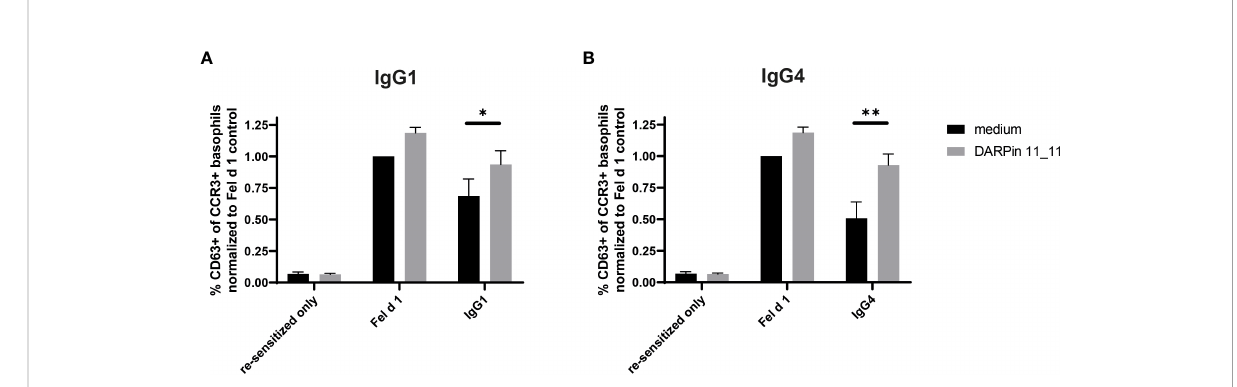
FIGURE 4 Inhibition of degranulation by IgG1 and IgG4 can be abolished through blocking of Fc g RIIb. Whole blood from four non-allergic subject was collected, desensitized with a disruptive DARPin 53-79 before resensitizing with Fel d 1 speci fi c IgE F127. Primed basophils were treated either with medium (RPMI/IL-3) or with medium containing 1000 nM DARPin 11_11 for 30 min at 37°CC. Basophils are then incubated with either Fel d 1 alone or with Fel d 1 pre-complexed with IgG1 (A) or IgG4 (B) G078 at a concentration of IgG of 100 nM). Results are expressed as the percentage of CD63 positive basophils of total basophils (CCR3+ basophils) normalized to percentage of CD63+ basophils in the Fel d 1 medium control. Data of four different donors is given as mean ± SEM. For statistical analysis two-tailed paired t-tests were performed. * for p ≤ 0.05, ** for p ≤